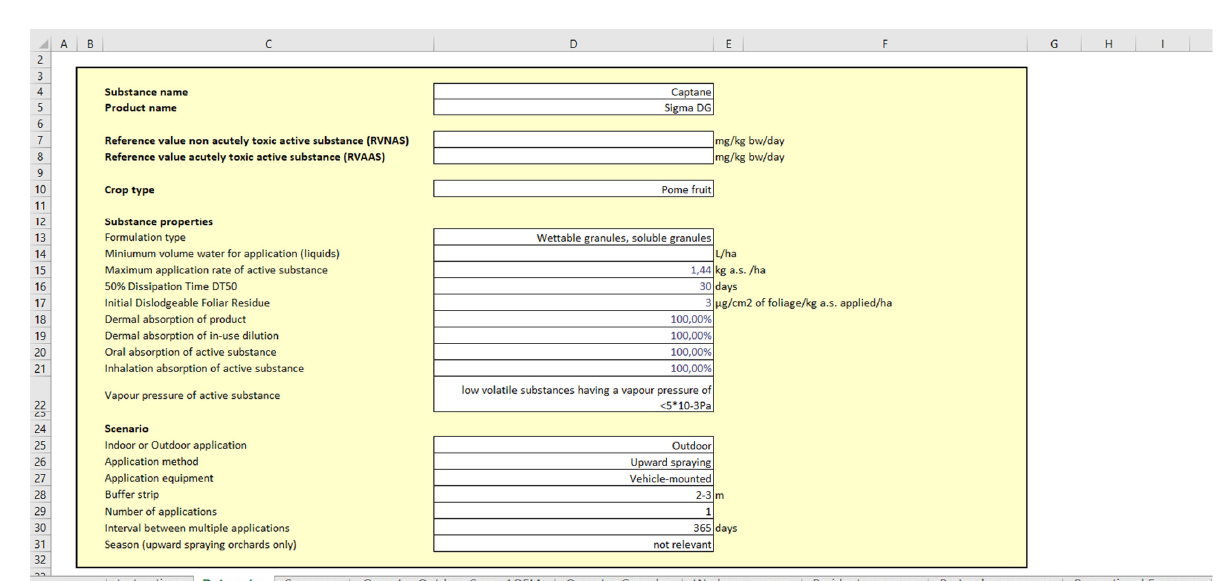
Int. J. Environ. Res. Public Health 2022 , 19 , x FOR PEER REVIEW Figure A2. Data entry worksheet. Figure A2. Data entry worksheet.